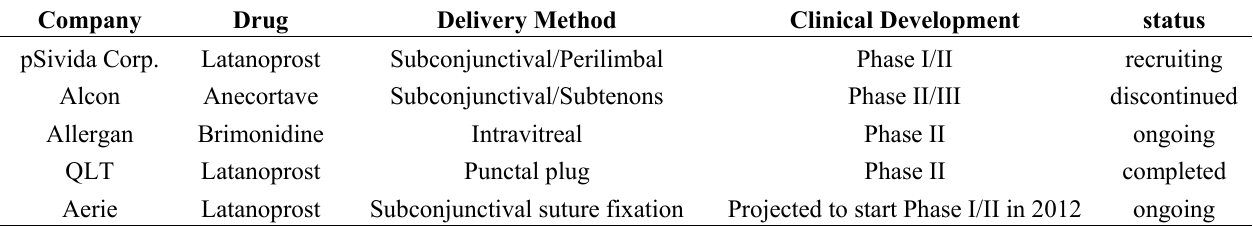
Table 1. Glaucoma intraocular pressure (IOP) lowering sustained release (SR) platforms that have reached clinical